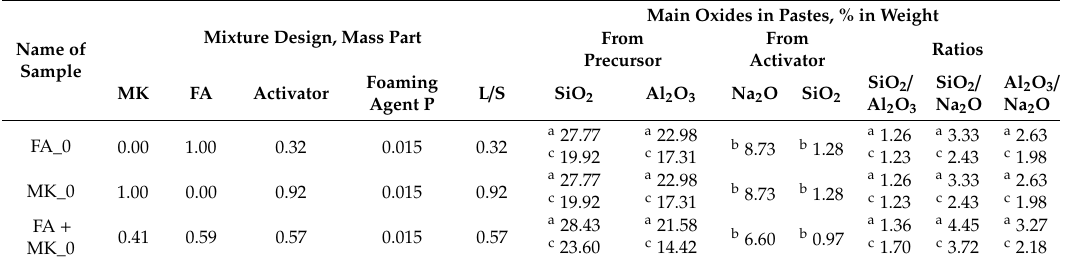
Table 2. Compositions of studied samples and amount of main oxides in